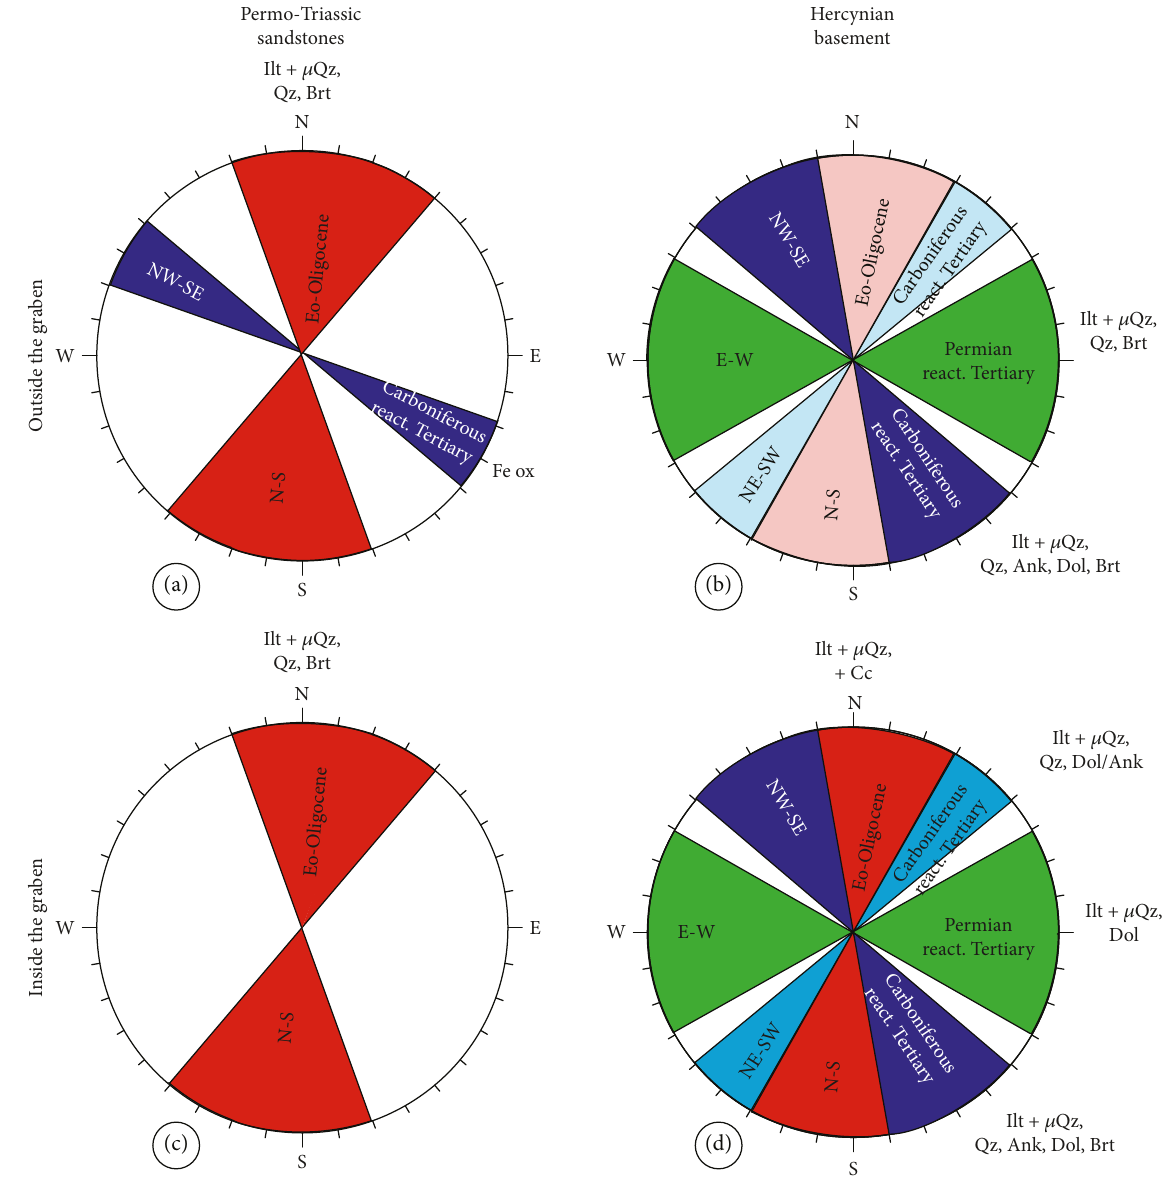
Figure 14: Synthesis of the main observed fracture directions with associated fi lling in the Hercynian granite and the Permo-Triassic sandstones inside and outside the graben. The Ilt + μ Qz combination is generally associated with